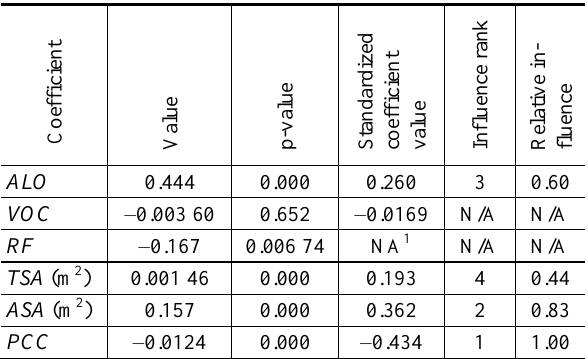
Table 2. Regression coefficients statistics for macro-level